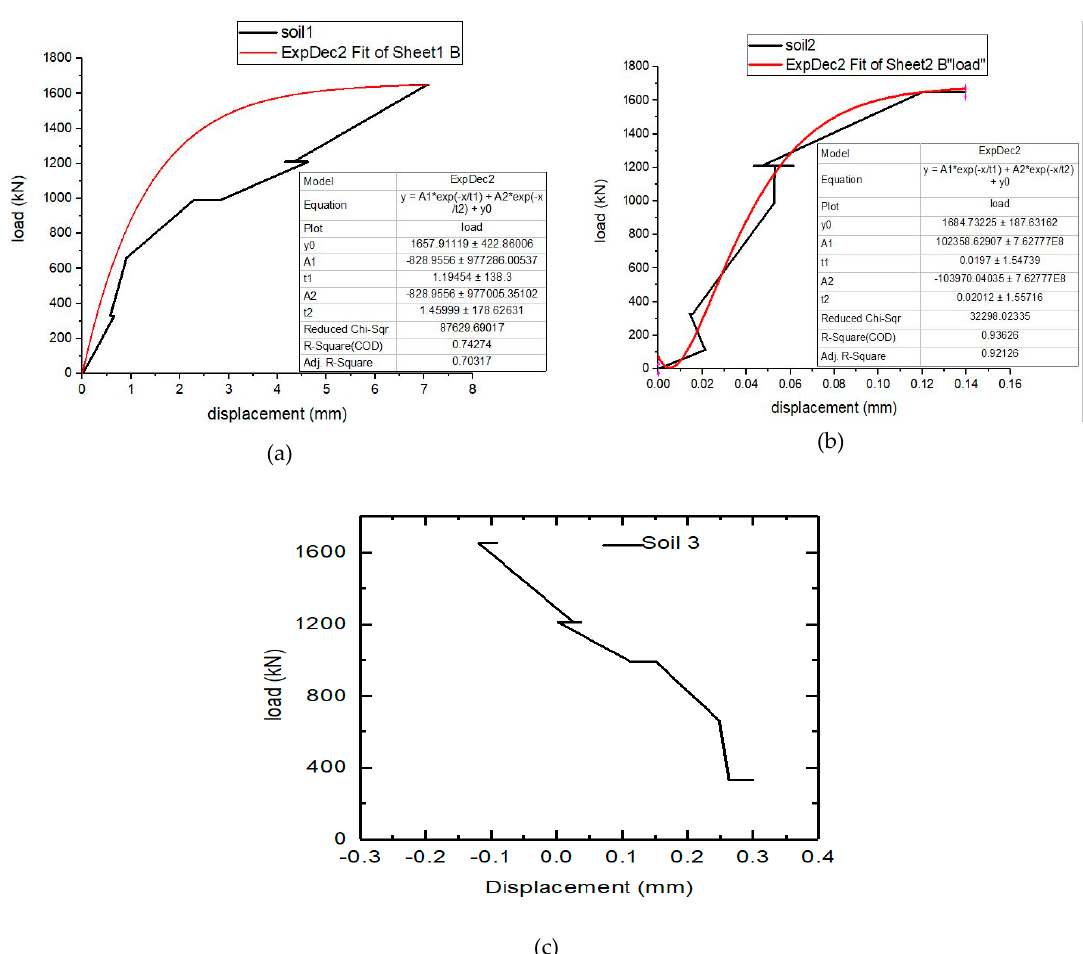
Figure 10. The relation of the first two soil displacement and the lateral load applying on the pile; ( a ) FE Simulation result for the soil 1; ( b ) FE Simulation result for the soil 2; ( c ) FE Simulation result for the soil 3.